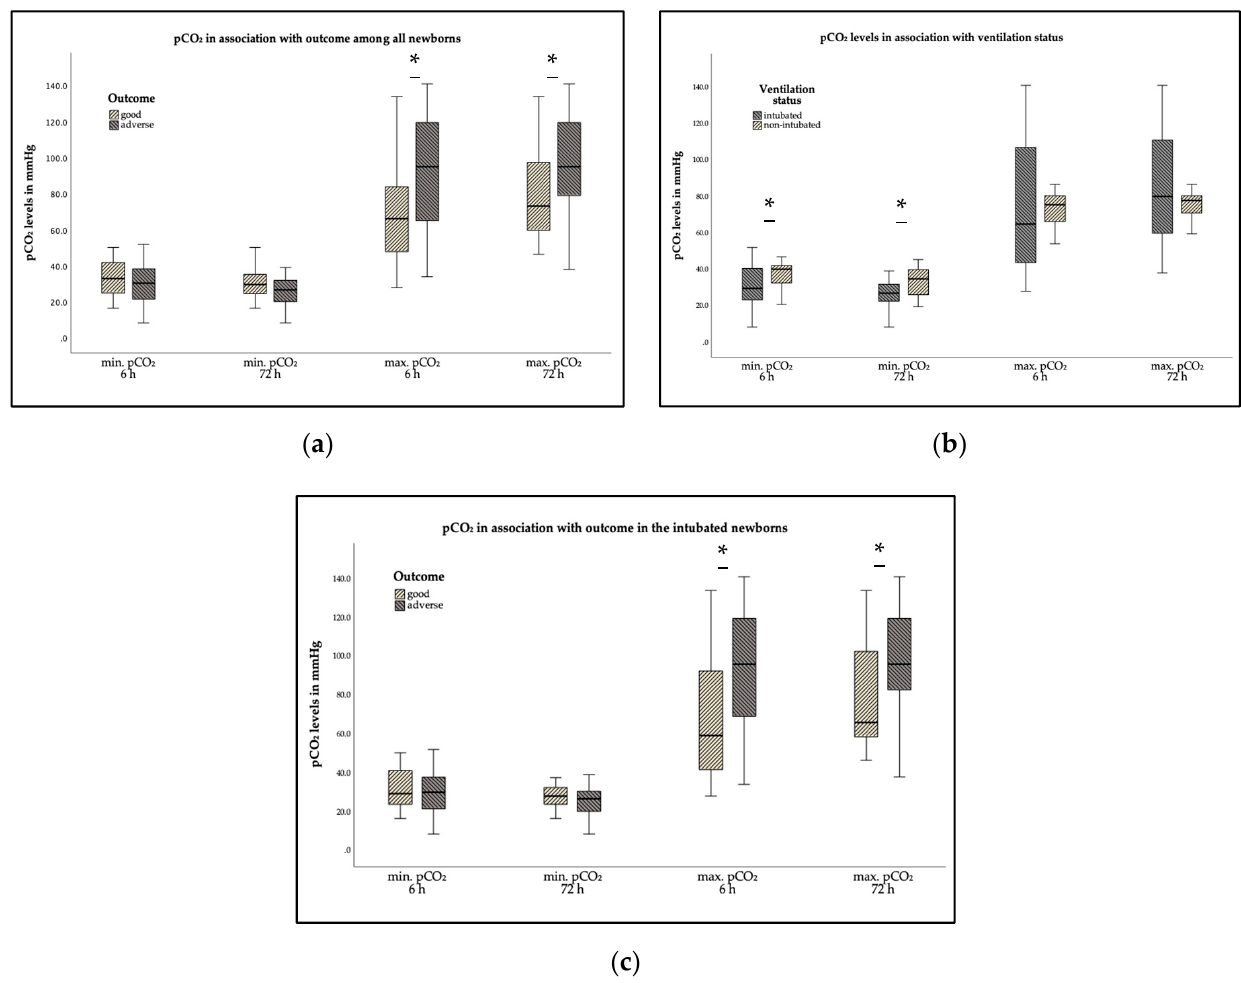
Figure 1. Box and whiskers plot representations. Minimum and maximum pCO 2 over the first 6 and 72 h of life (HOL): ( a ) in association with adverse outcomes among all included cooled asphyxiated neonates, ( b ) in association with ventilation status, and ( c ) in association with adverse outcomes in the group of intubated newborns. * p < 0.05.